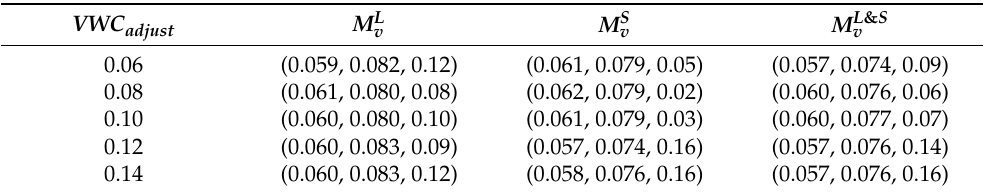
Table 8. Sensitivity test of soil moisture retrieval validation at soybean fields for different VWC adjust